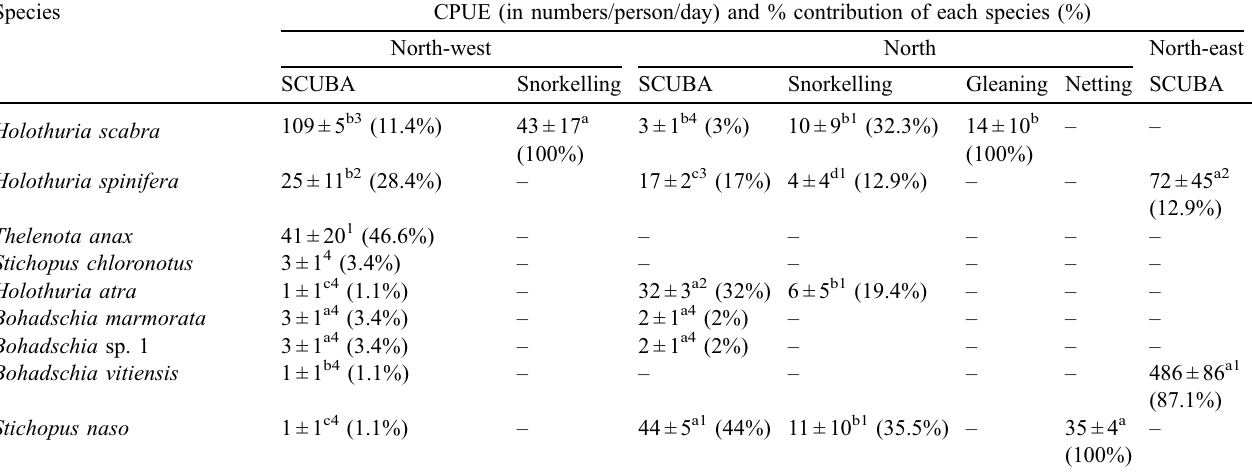
Table 4. Variation in CPUE (in numbers/person/day) of sea cucumber species and their percentage contribution (%) to the total landings in the north, north-west and north-east coast of Sri Lanka from November 2015 to January 2017. Species CPUE (in numbers/person/day) and % contribution of each species (%)